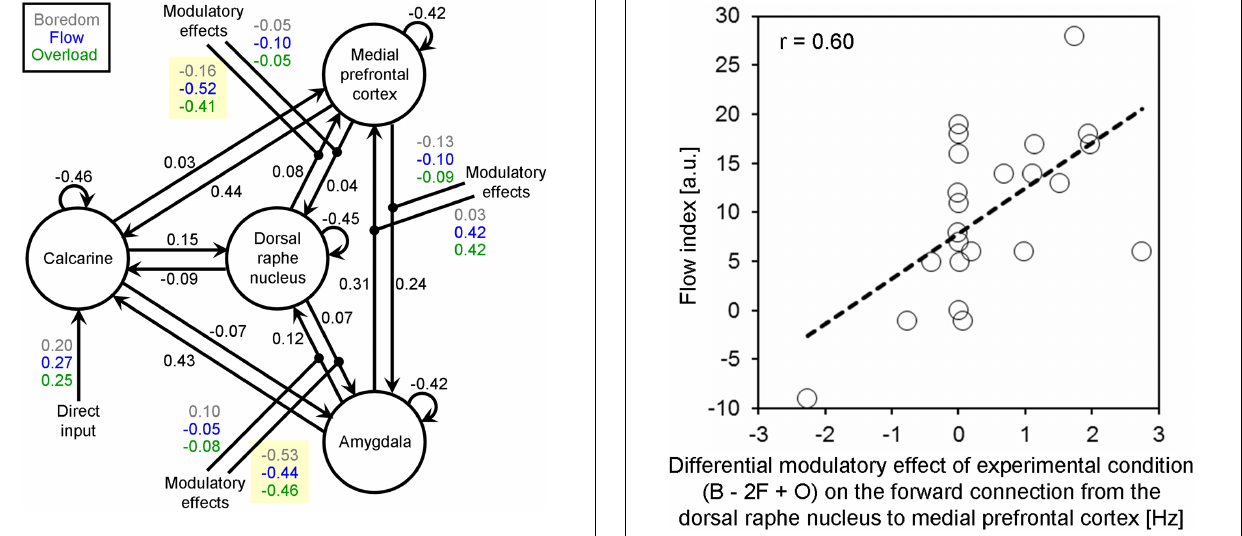
FIGURE 3 | The differential modulatory effect between experimental conditions on the forward connection from the DRN to the medial prefrontal cortex significantly ( r = 0.60, p = 0.001) predicted participants’ flow index (arbitrary unit, a.u.). The term “differential modulatory effect” refers to the difference in the rates of change of MPFC activity (caused by the DRN) between experimental conditions, calculated using the formula “B − 2F + O”. The respective subject-specific parameters were derived from the BMS.DCM.rfx.bma.mEps structure after Bayesian Model Averaging over models of the winning family (i.e., family 1; see Results section for